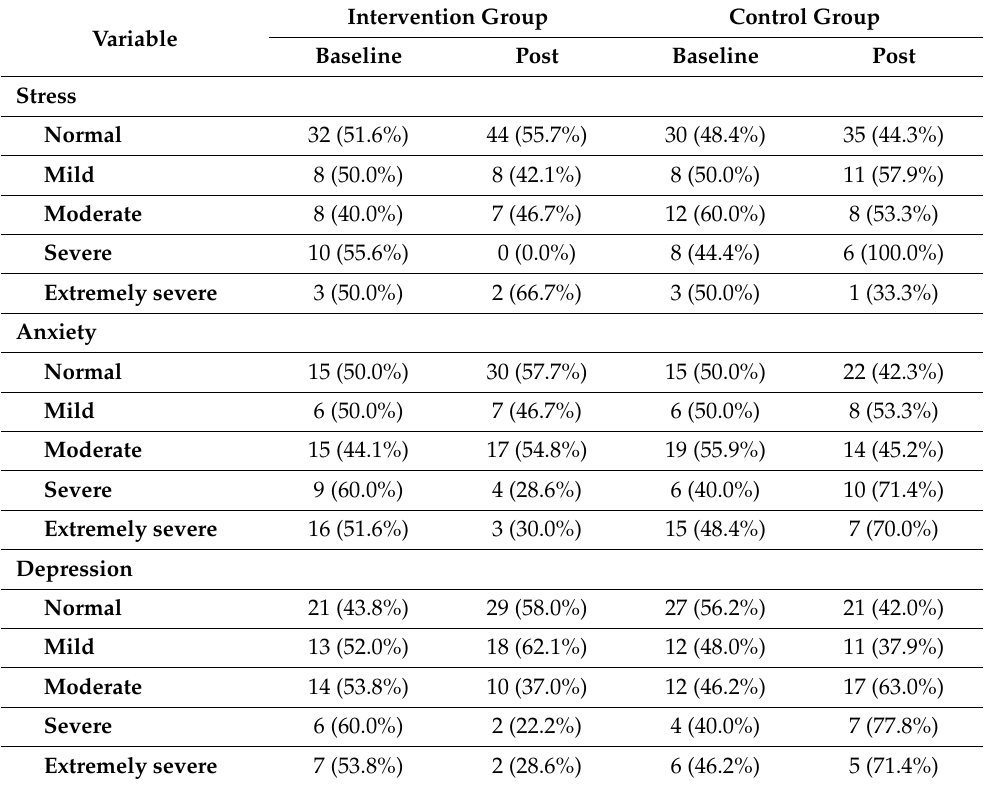
Table 3. Frequency distribution of participants’ levels of stress, anxiety, and